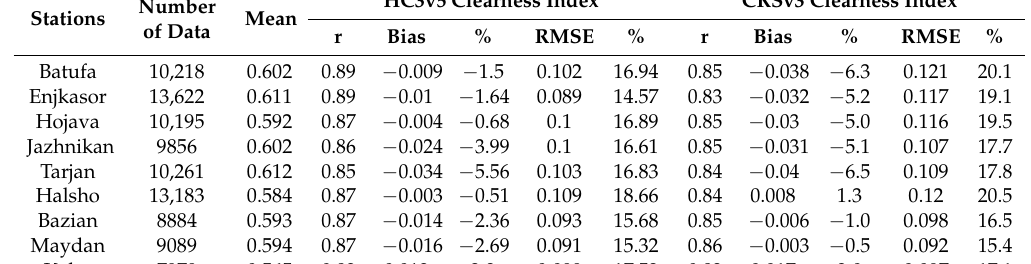
Table 4. Validation of hourly GHI under all-sky conditions for the clearness index. Mean, bias and RMSE units are W/m 2 .